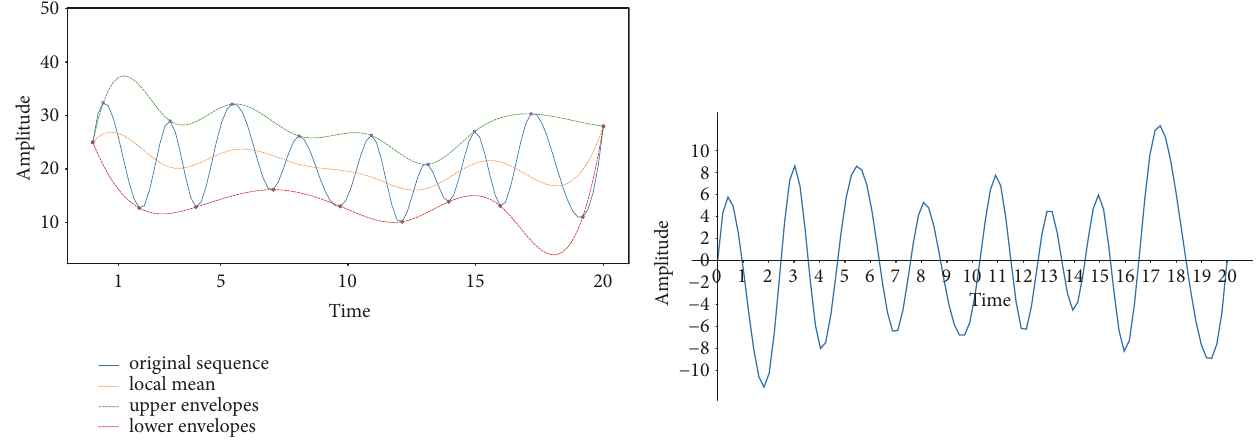
Figure 1: An illustration of